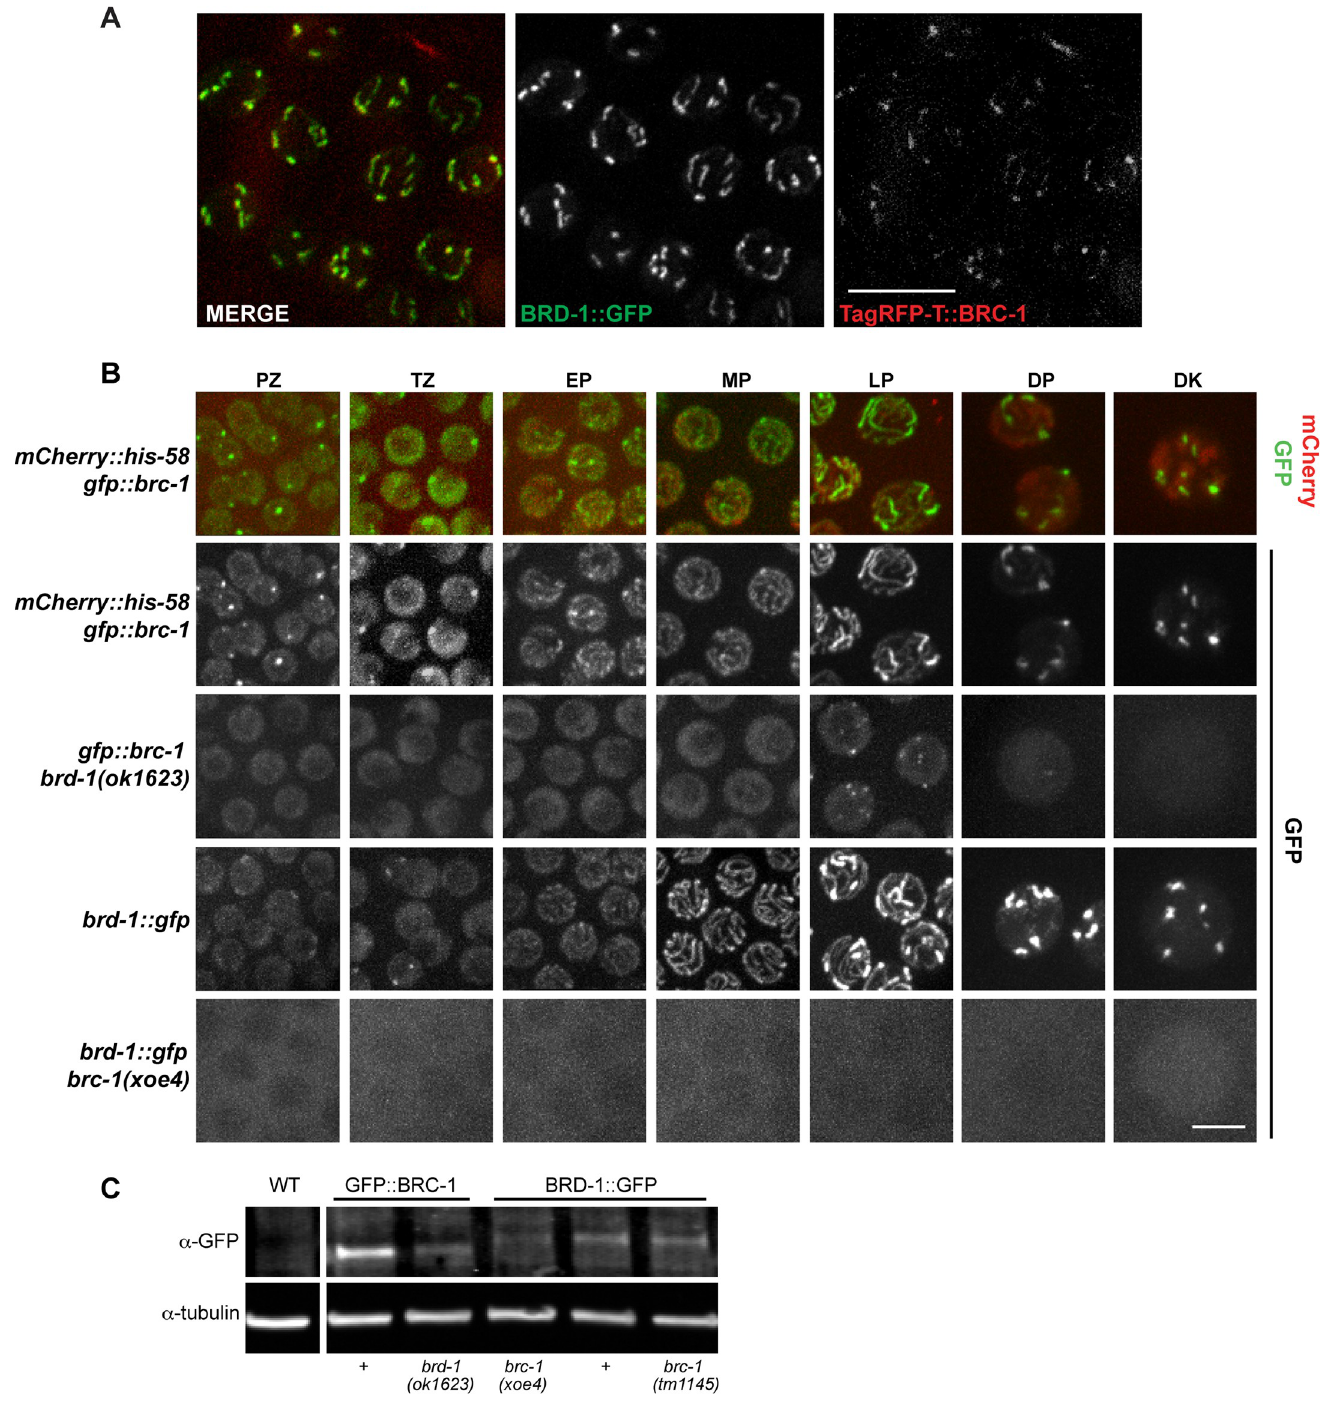
Fig 3. BRC-1 and BRD-1 are inter-dependent for localization. A) Co-localization between BRD-1::GFP (green) and TagRFP-T::BRC-1 (red) at late pachytene in live worms. Scale bar = 10 μ m. B) Stills of germline nuclei from live worms expressing GFP::BRC-1 and mCherry::Histone H2B ( mCherry :: his-58; gfp :: brc-1 ); merge and GFP channel; top two panels, respectively. GFP::BRC-1 expression in brd-1(ok1623) mutant at indicated meiotic stages. Bottom two panels show BRD-1::GFP localization in wild type and the brc-1(xoe4) mutant. Images are projections through half of the gonad. TZ = transition zone; EP = early pachytene; MP = mid pachytene; LP = late pachytene; DP = diplotene; DK = diakinesis. Scale bar = 5 μ m. C) Immunoblot of whole worm extracts from indicated worms probed with anti- GFP and α -tubulin antibodies. Lane 1 = N2: wild type; Lane 2 = JEL515: gfp :: brc-1; Lane 3 = JEL520: gfp :: brc-1 brd-1(ok1623); Lane 4 = JEL744: brc-1(xoe4) brd-1 :: gfp ; Lane 5 = JEL657: brd-1 :: gfp ; Lane 6 = JEL678: brc-1(tm1145) brd-1 :: gfp .